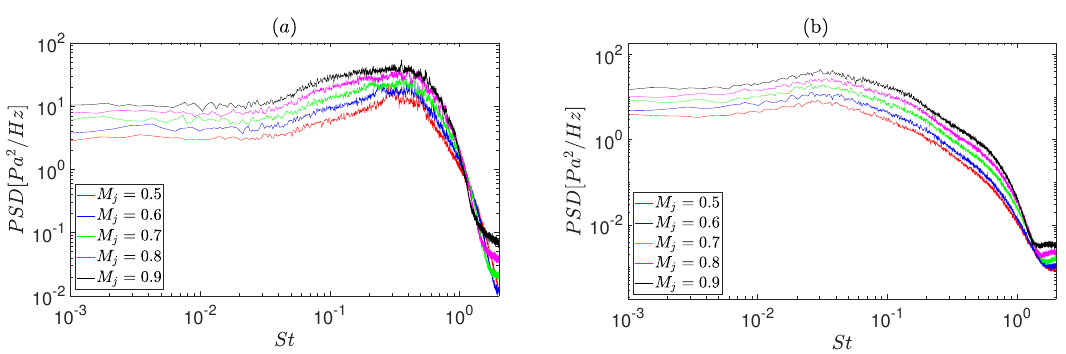
Figure 3. Mach number effect on the pressure autospectra for the jet–plate radial distance H/D = 0.75: ( a ) x/D = 5; ( b ) x/D = 25.